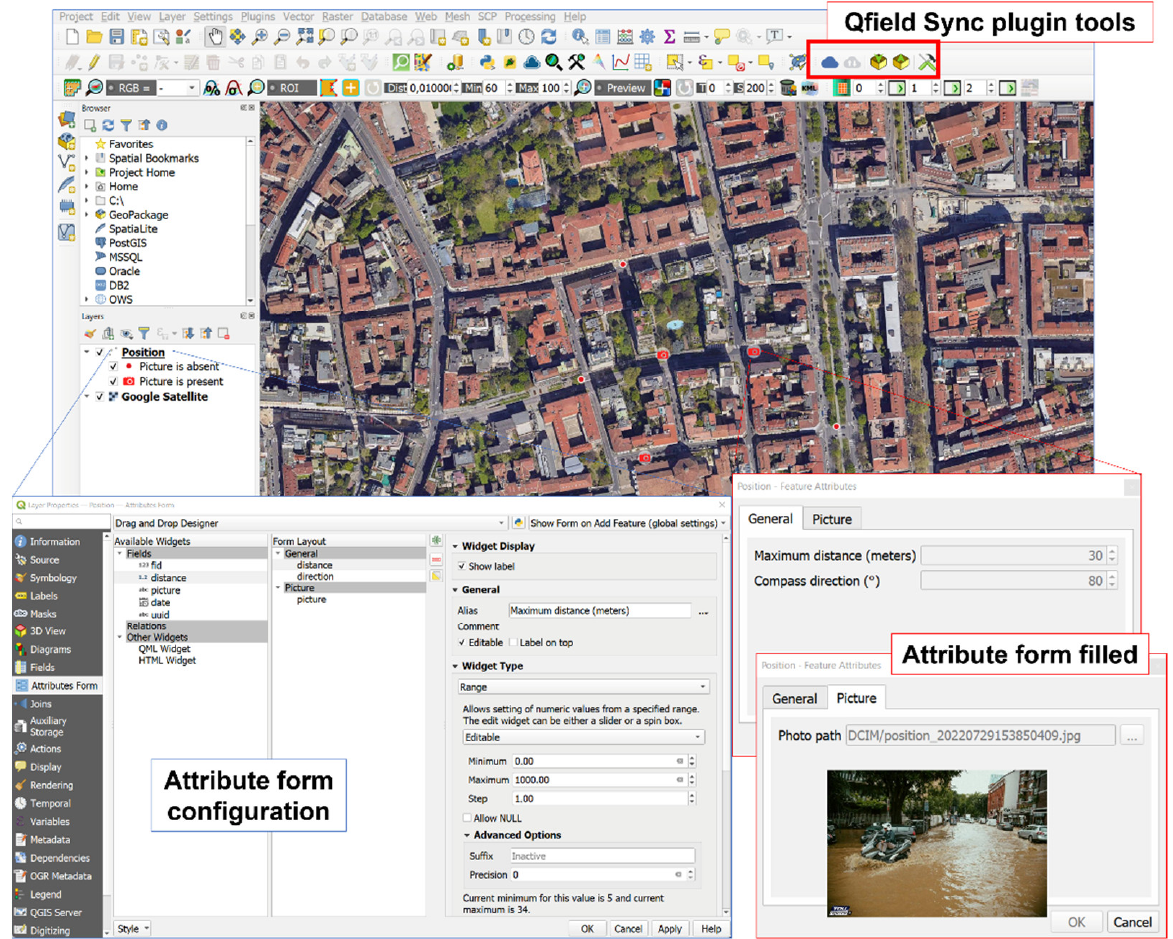
Figure 12. Screenshot of the QGIS project, showing the map with the details acquired in the field, an example of the Attribute form configuration, the Attribute form filled, and the tool to Sync the project in the Cloud.